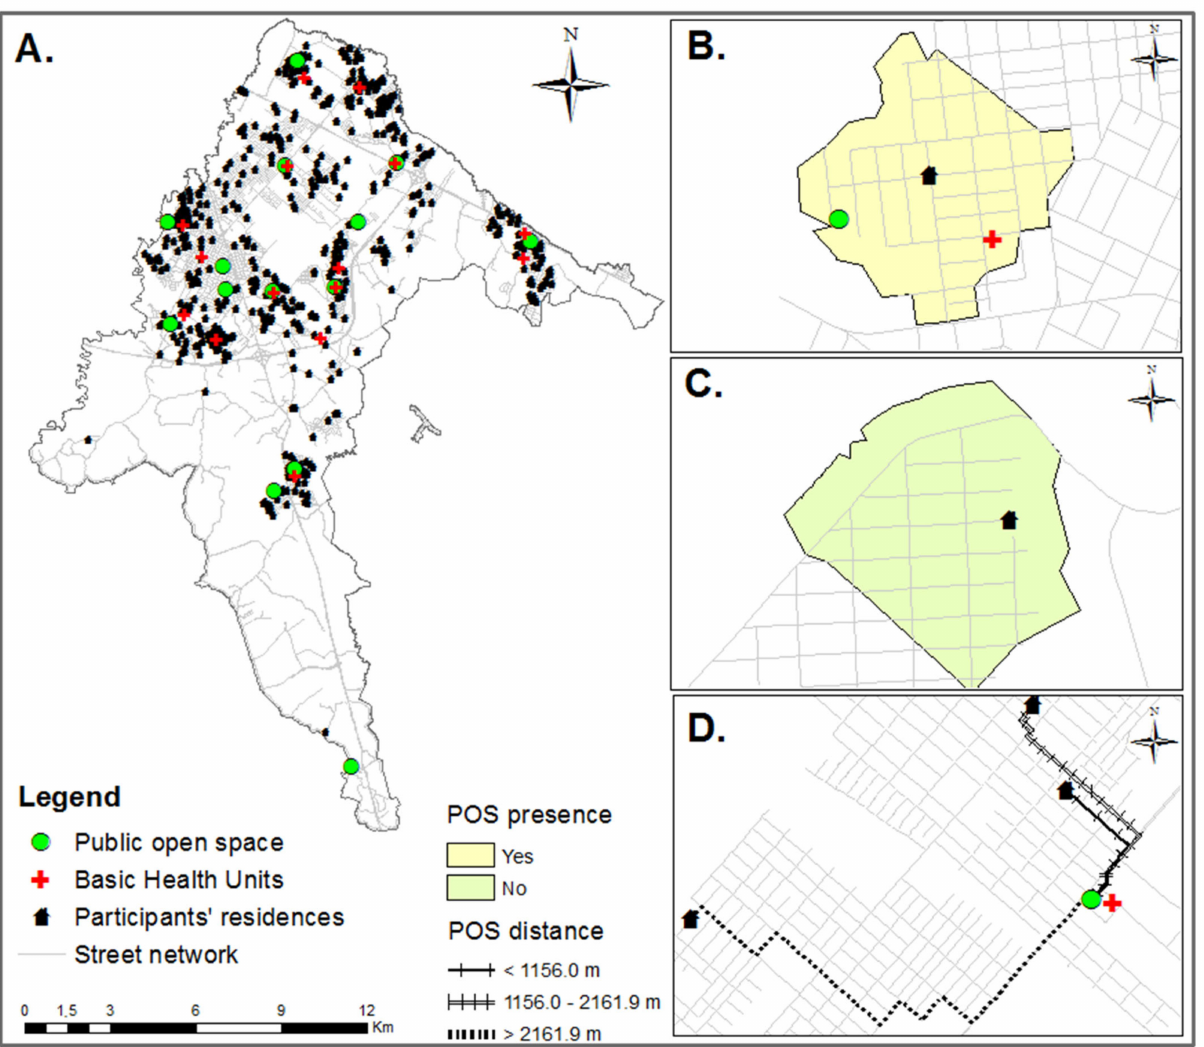
Figure 1. ( A ): Public open space (POS) ( n = 14), Basic Health Units ( n = 15), and the participants’ residence ( n = 615) spatial locations; ( B ): POS present (500-m street network buffer); ( C ): POS absent; ( D ): shortest distance between residence and POS (tertiles in meters). S ã o Jos é dos Pinhais, Paran á , Southern Brazil,